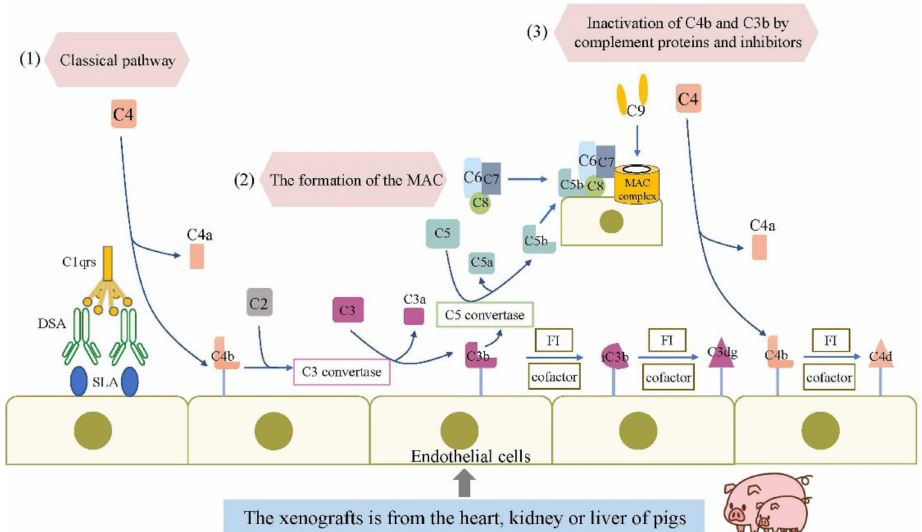
Figure 1. Complement activation in antibody-mediated xenorejection. (1) The classical pathway of complement is activated when antibodies (referred to as DSA) bind to SLAs expressed on endothelial cells of the transplanted organ. Classical pathway activation causes the cleavage of C4, and C4b is covalently attached to target surfaces. C4b can go on to form convertases and soluble mediators that perpetuate and amplify the complement cascade. C3b can covalently connect with target cells and regulate them for enhanced phagocytosis. (2) Activation of C3 leads to the formation of a C5 convertase, which cleaves C5 into C5a and C5b. C5b recruits several other complement proteins to the cell surface and ultimately initiates the formation of the MAC. MAC forms pores in the cell membrane and causes cell lysis at high concentrations. (3) The C4b and C3b molecules can be targeted by complement regulatory proteins and inhibitors such as FI to inactivate them. Although they are no longer catalytically active, the C4d and C3dg fragments remain covalently linked to the target cells and are a marker of early complement activation. Abbreviations: DSA, donor-specific antibodies; MAC, membrane attack complex; SLA, swine leukocyte antigen; FI, factor